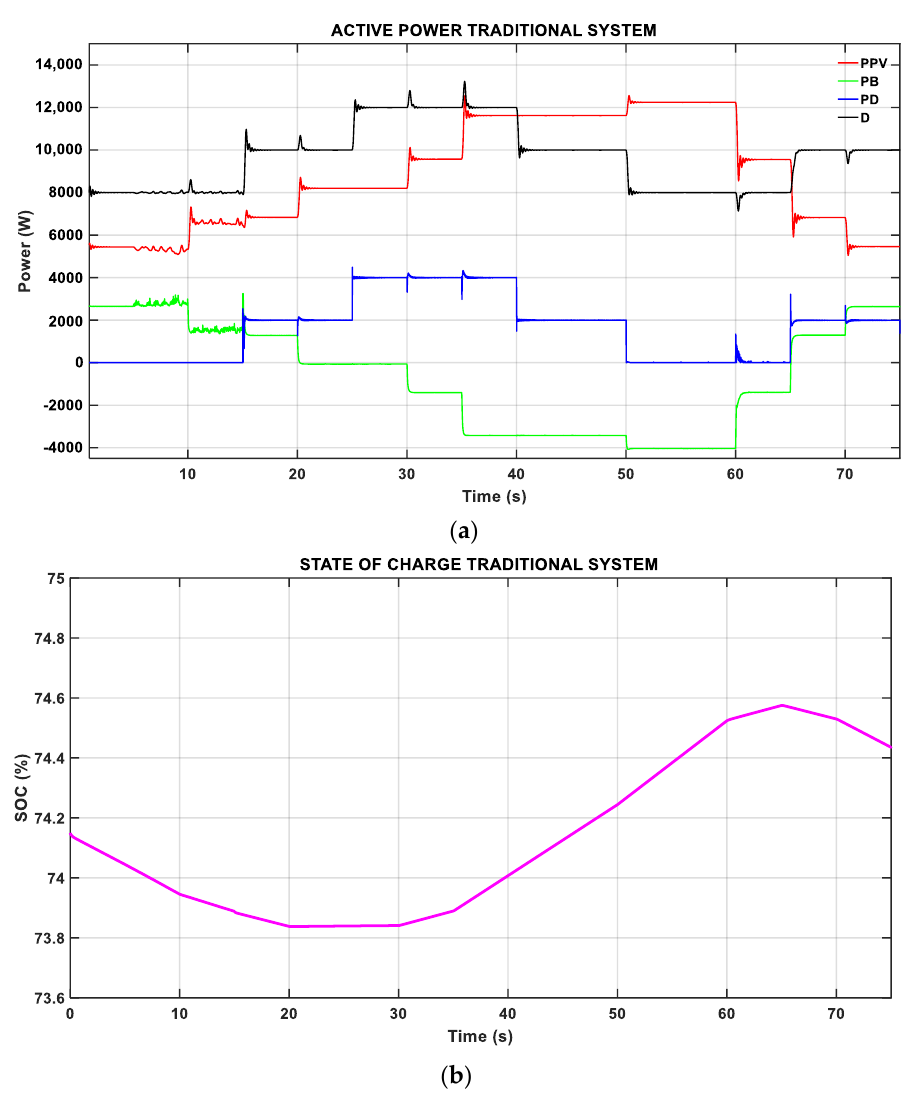
Figure 13. Microgrid performance without EMS: ( a ) Active Power Microgrid, ( b ) SOC of BESS.